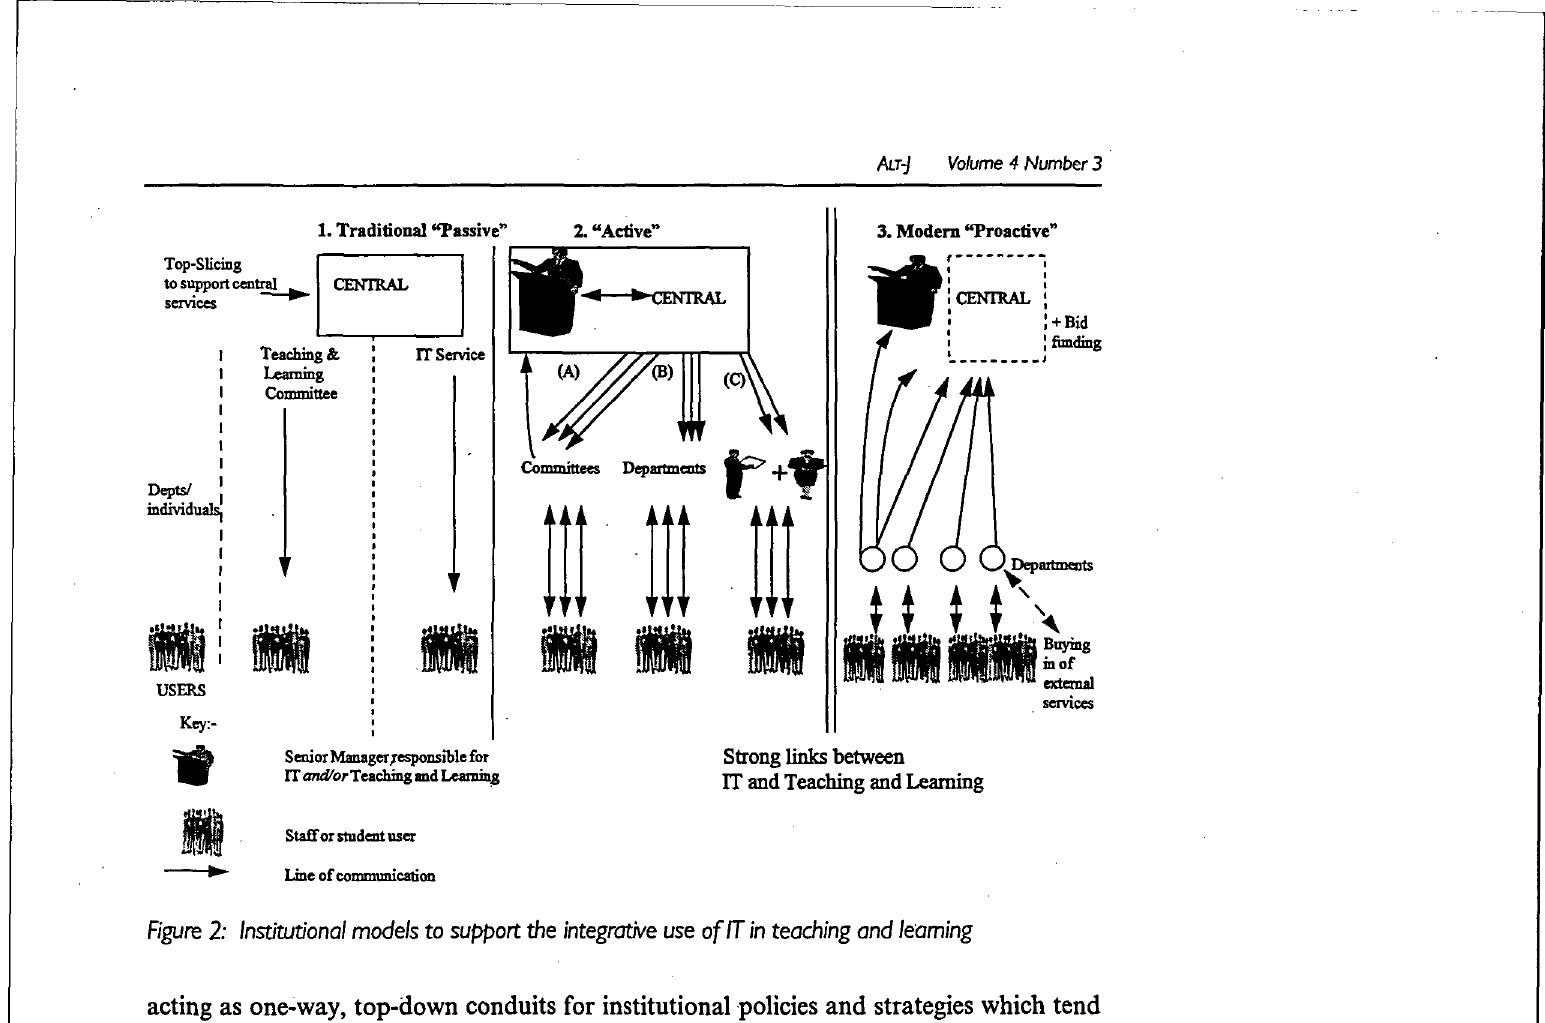
figure 2: Institutional models to support the integrative use of IT in teaching and learning acting as one-way, top-down conduits for institutional policies and strategies which tend to be rather weak. There is no single individual at a senior position in the centre whose prime and constant responsibility is IT and/or teaching and